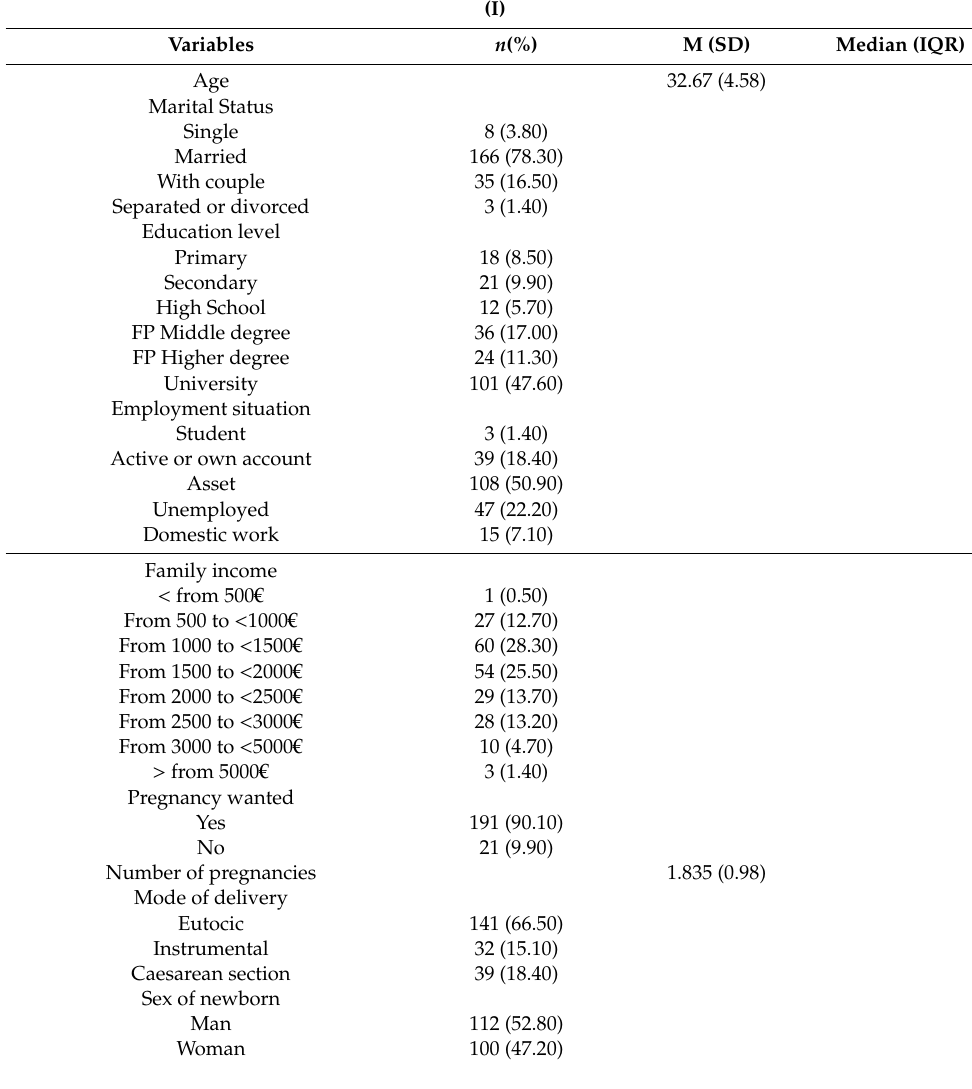
Table 1. Description of studied